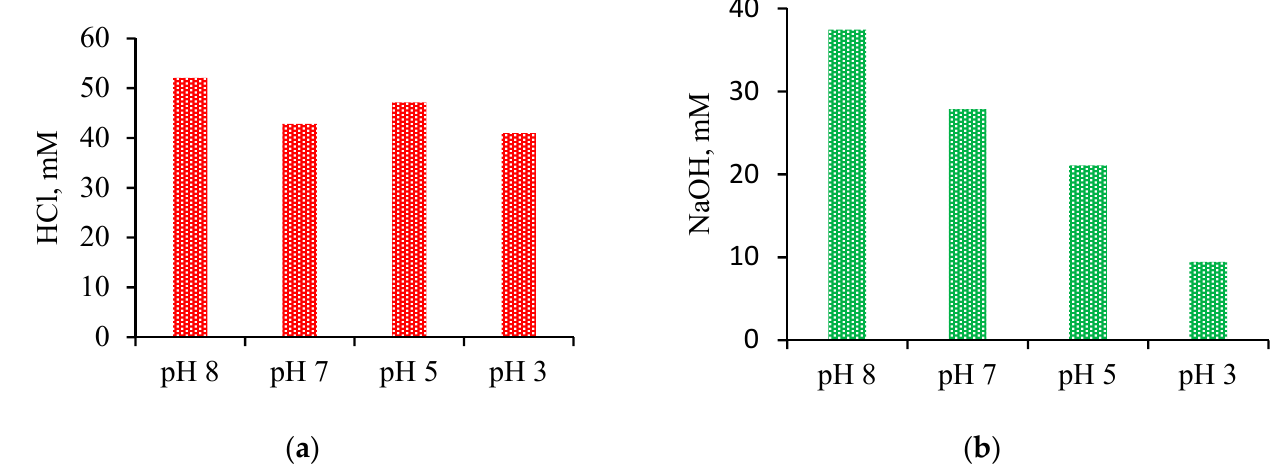
Figure 9. Acid ( a ) and base production ( b ) with different initial pH values at 60 min.